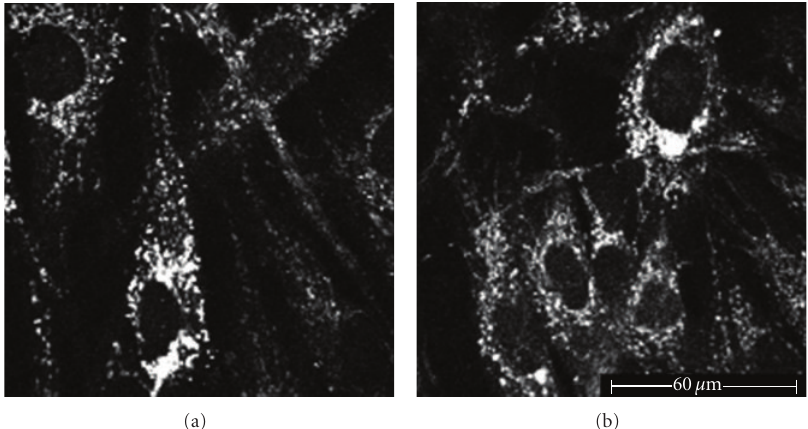
Figure 7: Fibroblast culture, 760 nm excitation wavelength. (a) Fibroblasts, before UVB irradiation, appearing as elongated cells; both the cellular bodies and the dendrites show an autofluorescent signal coming from the cytoplasmatic granules. (b) After UVB irradiation, some fibroblasts undergo morphologic alterations corresponding to necrosis.